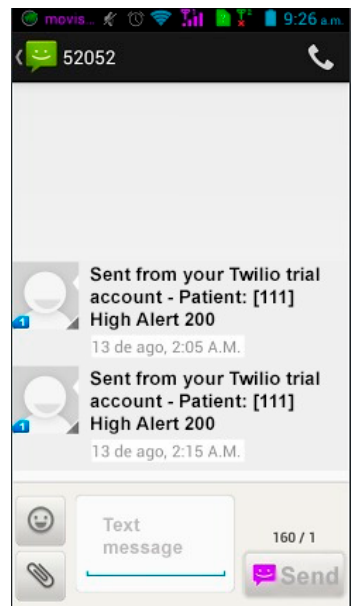
Figure 8. Example of sent messages when the level of glucose is higher than 200 mL.